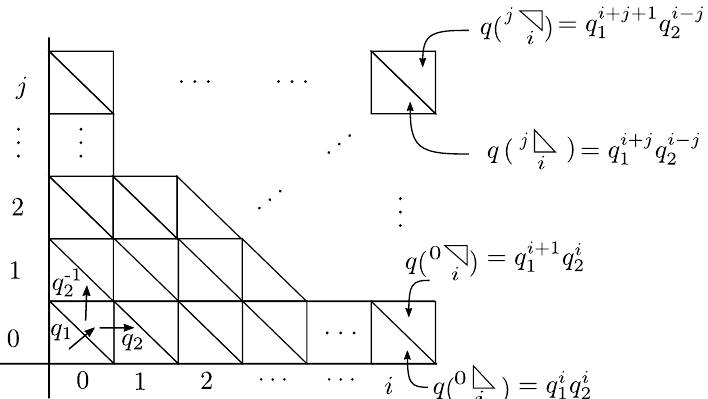
Figure 20. Coordinates of two-dimensional crystal. Each triangle is inside a box which has horizontal and vertical coordinates ( i, j ) . The blue triangle with horizontal parameter i and vertical parameter j has coordinate q i + j